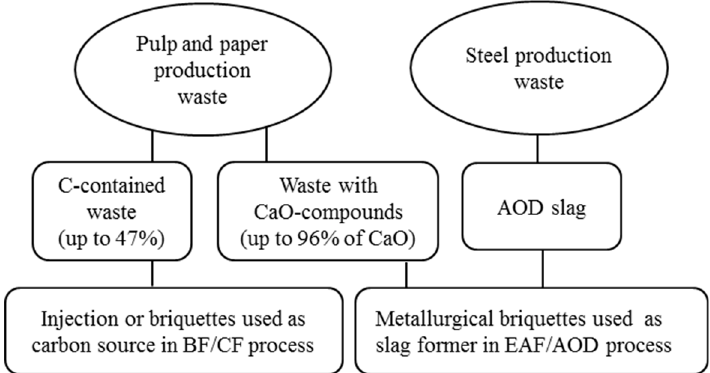
Figure 2. Application of wastes from pulp and paper industries in metallurgical processes.